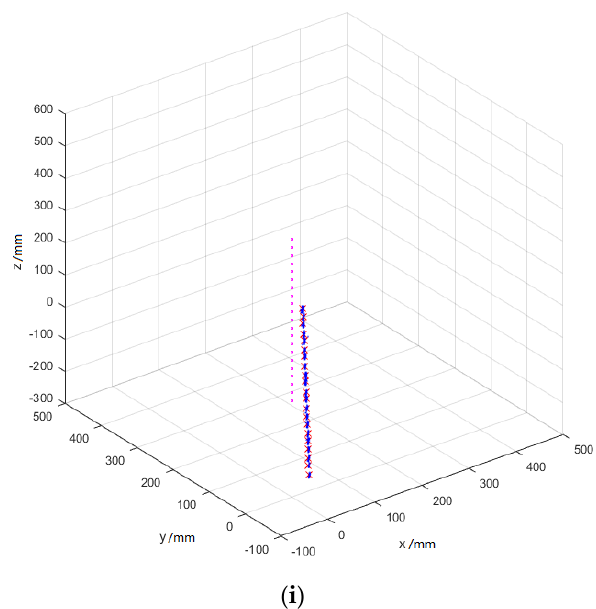
Figure 9. The jitter test results at different distances along each axis. ( a ) 1 m away, along the x -axis; ( b ) 1 meter away, along the y -axis; ( c ) 1 m away, along the z-axis; ( d ) 3 m away, along the x -axis; ( e ) 3 m away, along the y -axis; ( f ) 3 m away, along the z -axis; ( g ) 5 m away, along the x -axis; ( h ) 5 m away, along the y -axis; ( i ) 5 m away, along the z -axis. Table 3. Maximum jitter value for different measurement axes in a measurement range of 1 m to 5 m. Position Jitter Value (mm) Jitter scope Position Jitter Value (mm) Jitter Scope 1 m, along x